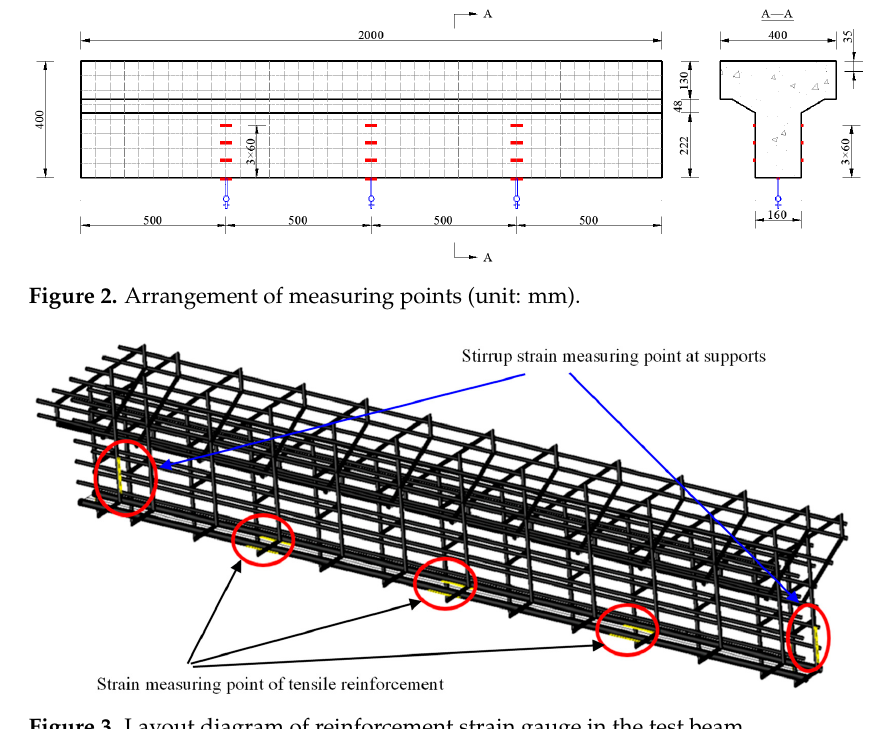
Figure 3. Layout diagram of reinforcement strain gauge in the test beam.